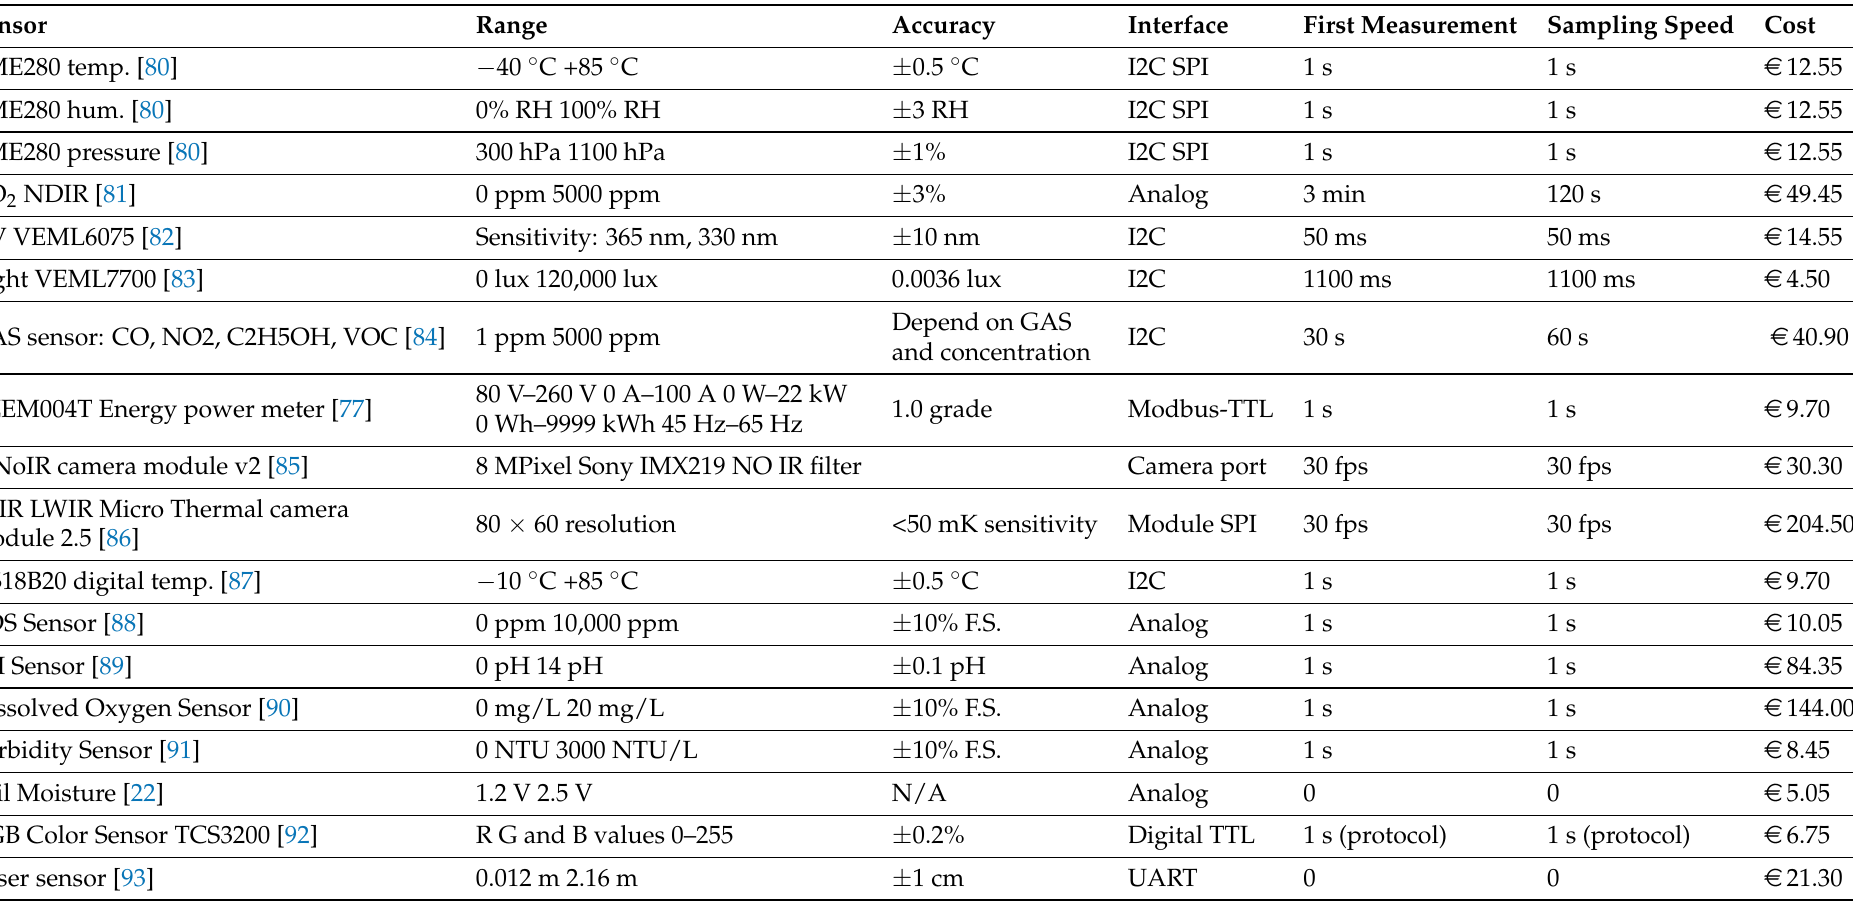
Table 1. Used sensors according to related